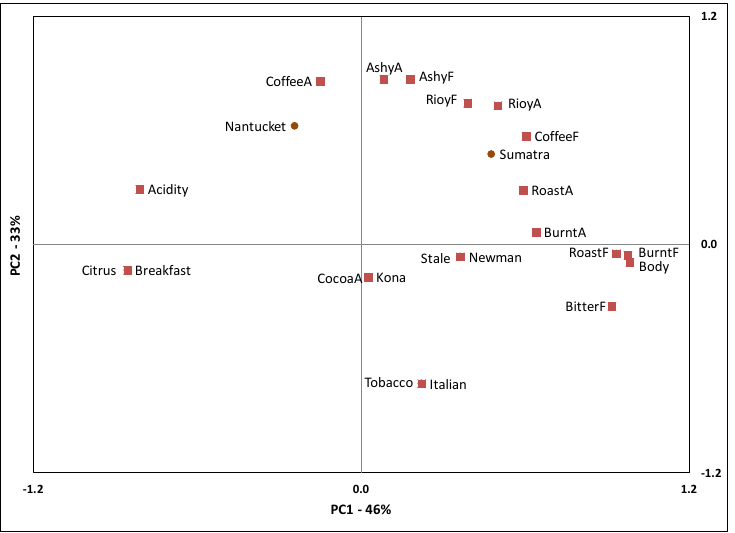
Figure 1. Principal component analysis (PCA) biplot of the sensory profiles of the six coffees generated by the coffee panel.